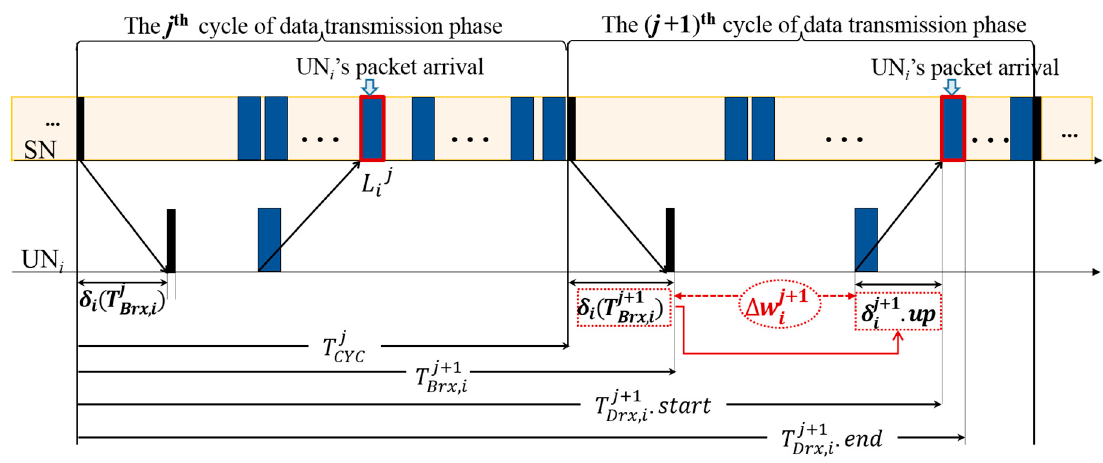
Figure 4. The transmission phase of the APD-TDMA.